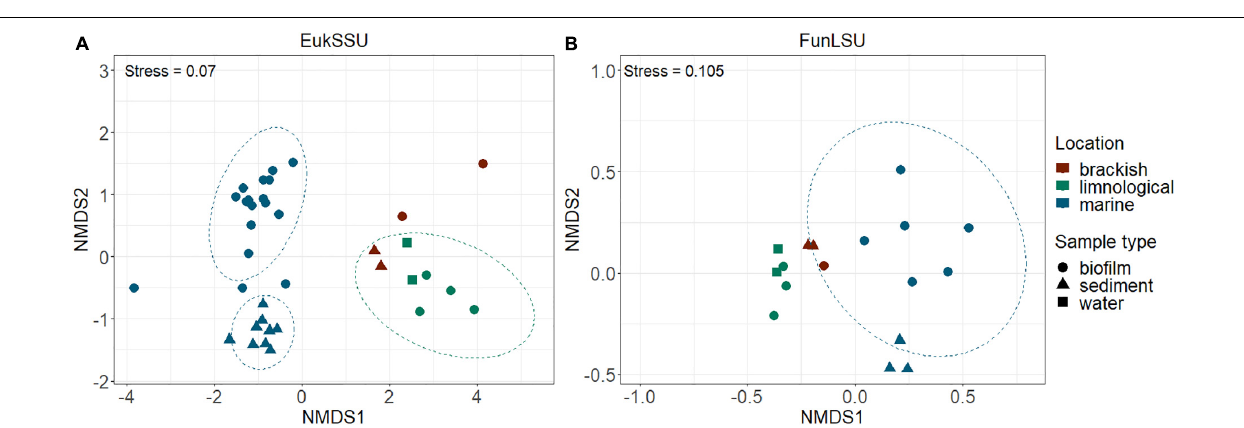
FIGURE 3 | NMDS multivariate clustering of communities according to location and sample type. In both (A) EukSSU and (B) FunLSU datasets marine samples separated from limnic ( post hoc pairwise t -test, p = 0.003) and brackish samples ( post hoc pairwise t -test, p = 0.006) as did biofilm from sediment samples ( post hoc pairwise t -test, p =